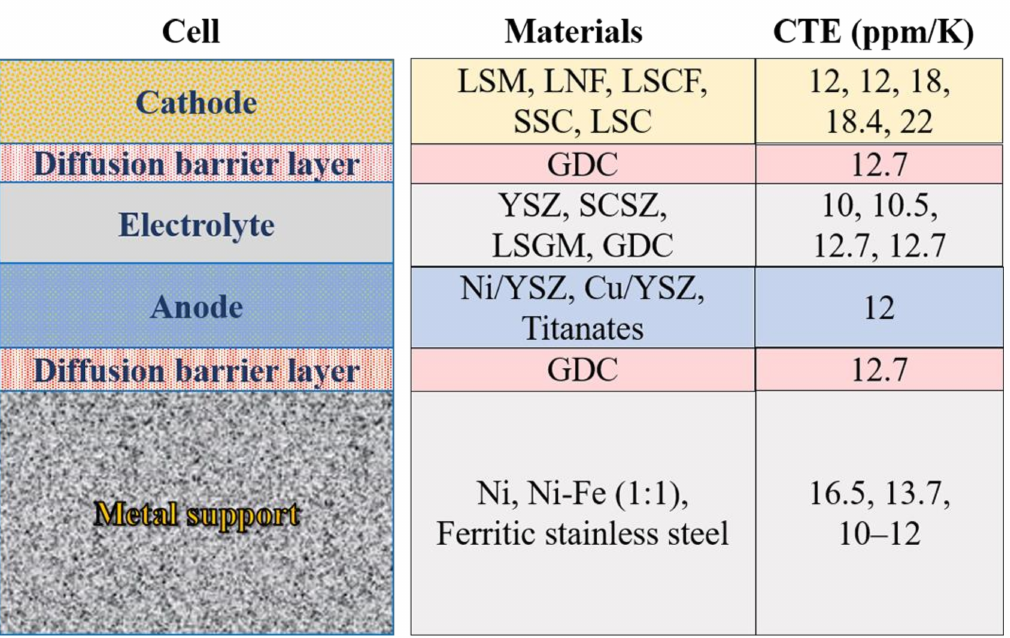
Figure 12. Candidate materials for MSCs, adapted from Ref. [9]. Lanthanum strontium manganite (LSM); Lanthanum nickel ferrite (LNF); Lanthanum strontium cobalt ferrite (LSCF); Strontium samarium cobaltite (SSC); Lanthanum Strontium Cobaltite (LSC); Scandia-ceria-stabilized zirconia (SCSZ); Lanthanum strontium gallium magnesium oxide